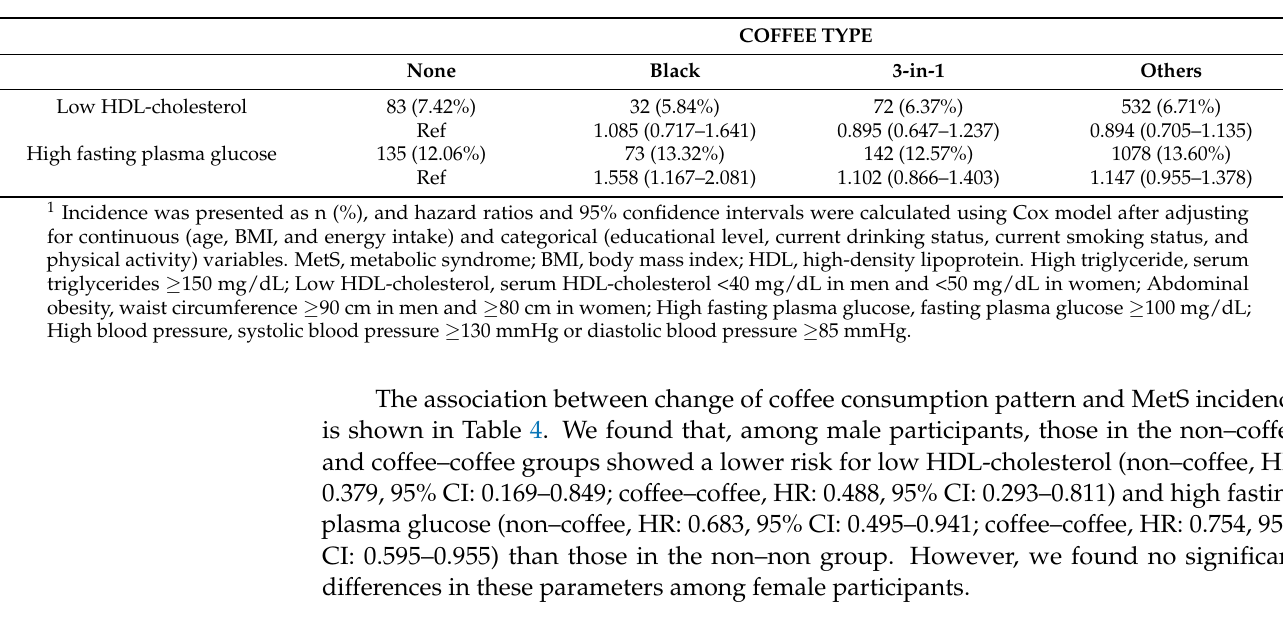
Table 4. The association between the change of coffee consumption pattern and incidence of MetS and its five components (reference group: non–non consumers) 1